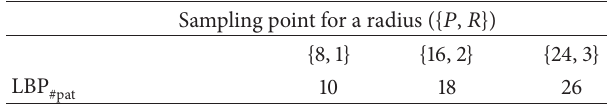
Table 2: Number of patterns (LBP #pat ) for different sampling points and radius ( {𝑃 , 𝑅} ) of the LBP descriptor.